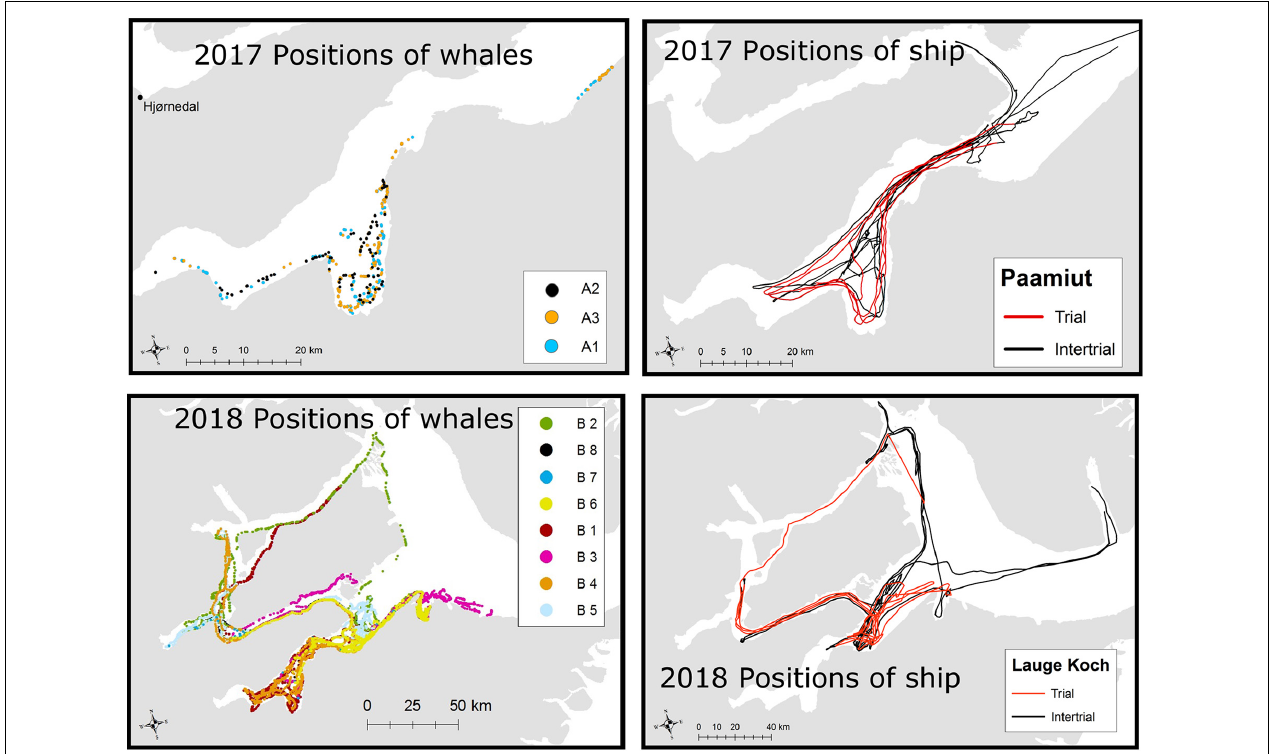
FIGURE 3 | Upper panel , left Tracks of three whales subject to airgun trials between August 14 and 20, 2017 in Gåsefjord. Hjørnedal is the locality for the tagging of whales. Upper panel, right : Track of the seismic vessel r/v Paamiut in Outer Gåsefjord and in Gåsefjord ( Figure 1 ). Red lines indicate effort with airgun shooting (trials), and black lines indicate effort without airgun activity (intertrials). Lower panel, left : Positions of eight narwhals tracked between August 24 and September 2, 2018 in Scoresby Sound. Lower panel, right : Positions of the seismic vessel HDMS Lauge Koch between August 24 and September 2, 2018 in Scoresby Sound. Red lines indicate periods with airgun shooting (trials), and black lines show periods without airgun activity.